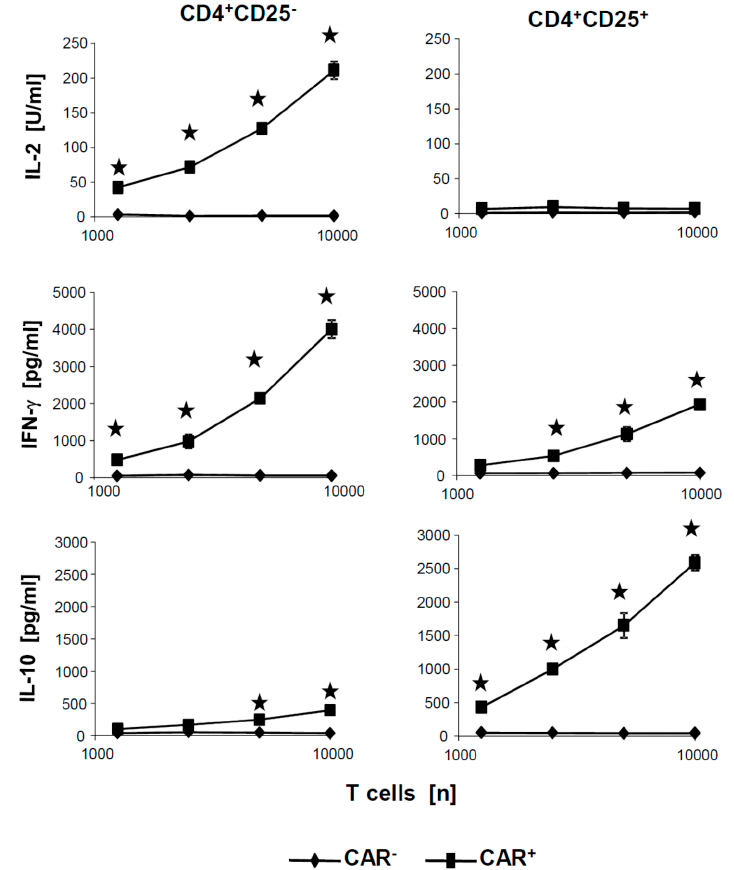
Figure 5. CD4 + CD25 − and CD4 + CD25 + T cells release a distinctive set of cytokines upon CAR engagement of target cells. CD4 + T cells with the anti-CEA CAR (1.25–10 × 10 3 CAR T cells/well) and non-modified T cells in same numbers were cocultivated for 48 h in 96-well tissue culture plates together with CEA + SW948 tumor cells (2.5 × 10 4 cells/well). Supernatants were analyzed for cytokines by ELISA. Data represent mean of technical replicates ± SD. Representative results out of three experiments are shown. Significant differences were calculated by the Student’s t test and significant data ( p < 0.05) were indicated by